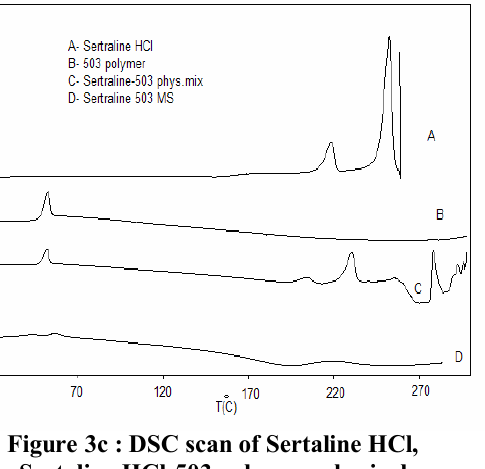
Figure 3c : DSC scan of Sertaline HCl, Sertaline HCl-503 polymer physical mixture, 503 polymer and Sertaline HCl microspheres.